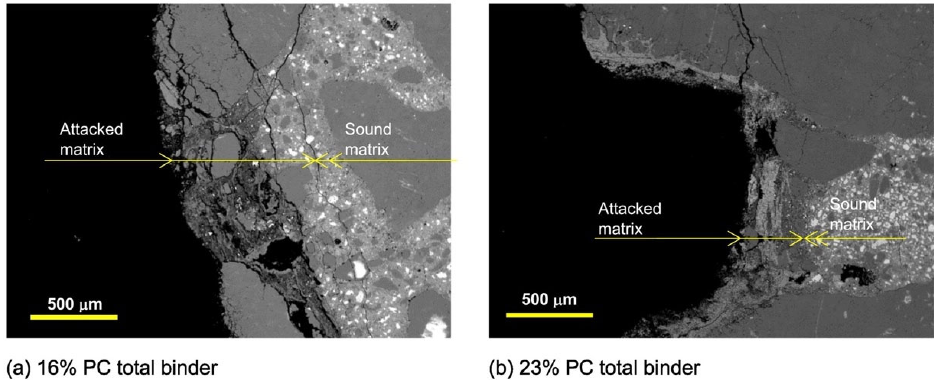
Figure 2. ( a , b ) show typical backscattered electron micrographs of concrete containing 16 percent and 23 percent Potland cement that was exposed to biogenic H 2 SO 4 in a live well sewer for 120 months, respectively. (from Kiliswa et al.